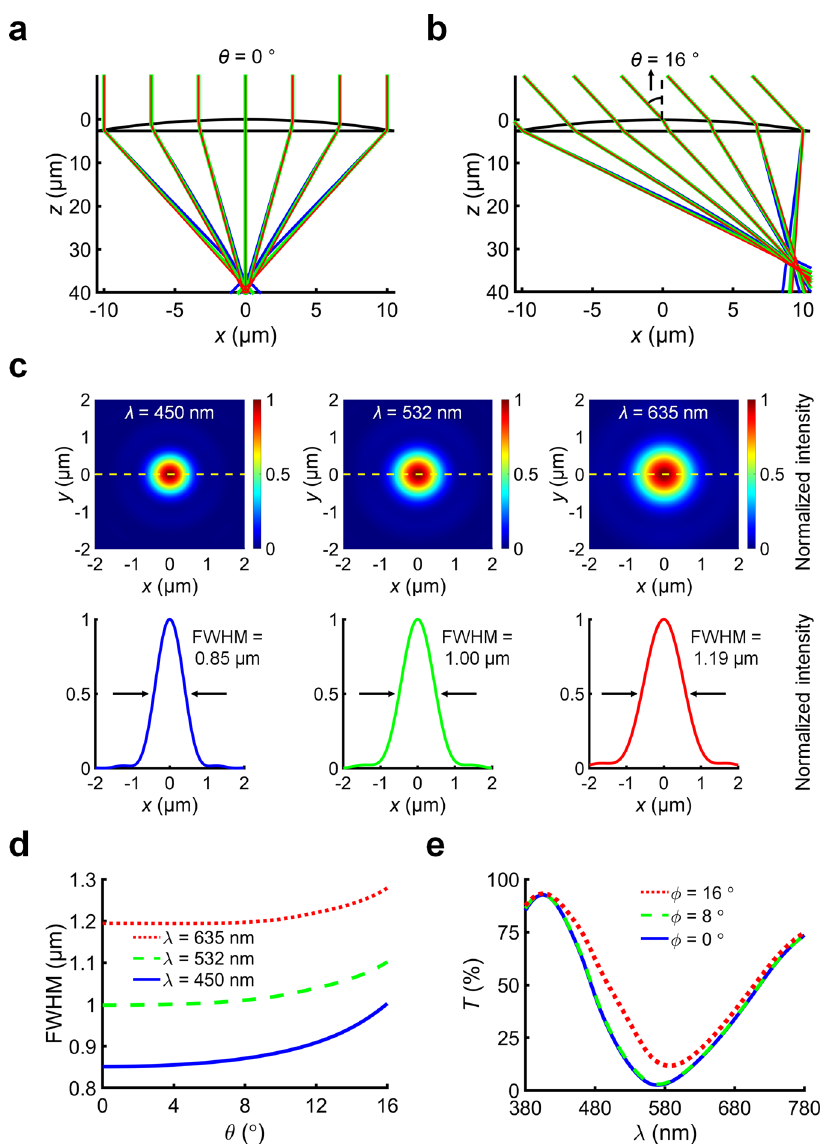
Fig. 2 Numerical simulations of the microlens and colour pixel. a , b Raytracing simulation of the microlens for fi eld angles θ = {0, 16}° that select the centre and corner pixel positions, respectively. c Simulated normalized electric fi eld intensity distribution of the x - y focal plane at z = 37 µ m, for θ = 0° and wavelengths λ = {450, 532, 635} nm, respectively. The focal spot size was calculated as the full width at half maximum (FWHM) of the normalized electric fi eld intensity pro fi le of the horizontal slice y = 0, indicated by the yellow dashed line. d Plot of the simulated FWHM vs. θ for the respective wavelengths. e Simulated transmittance spectra of a representative pixel (which comprised 5 × 5 nanopillars with diameter D = 0.3 µ m, height H = 1.2 µ m, pitch S = 1 µ m) for viewing angles ϕ = {0, 8,